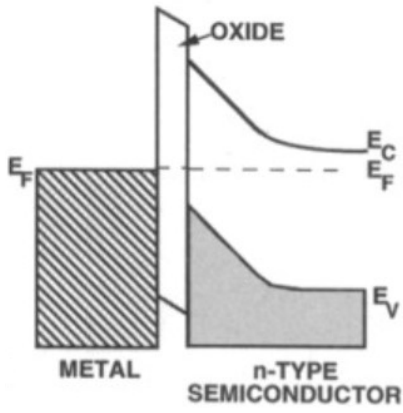
Figure 6. Energy band schematic of a metal–oxide–semiconductor interface [26] . 104